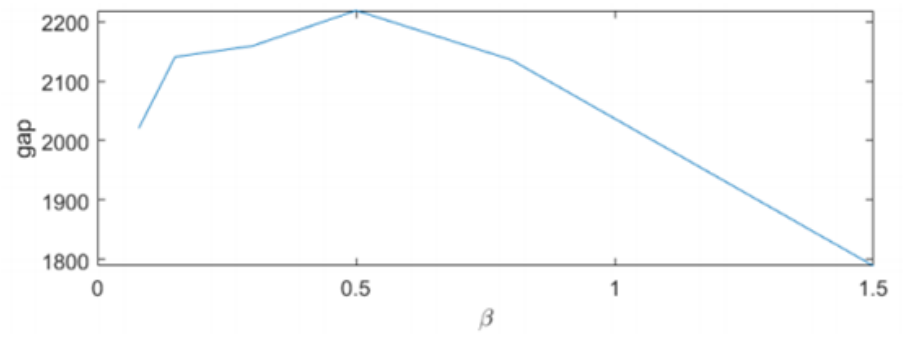
Figure 2. The gap vs. β in Example